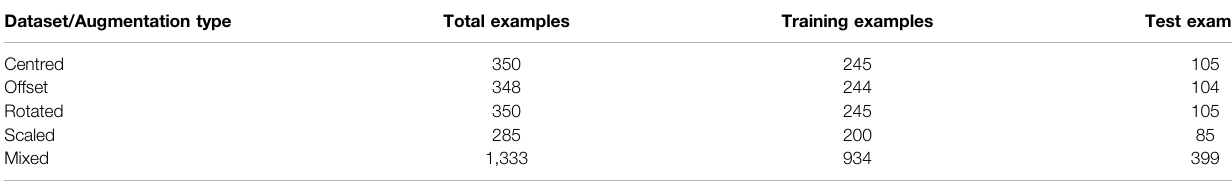
TABLE 2 | Example counts for each dataset used in the set of augmentation experiments. Dataset/Augmentation type